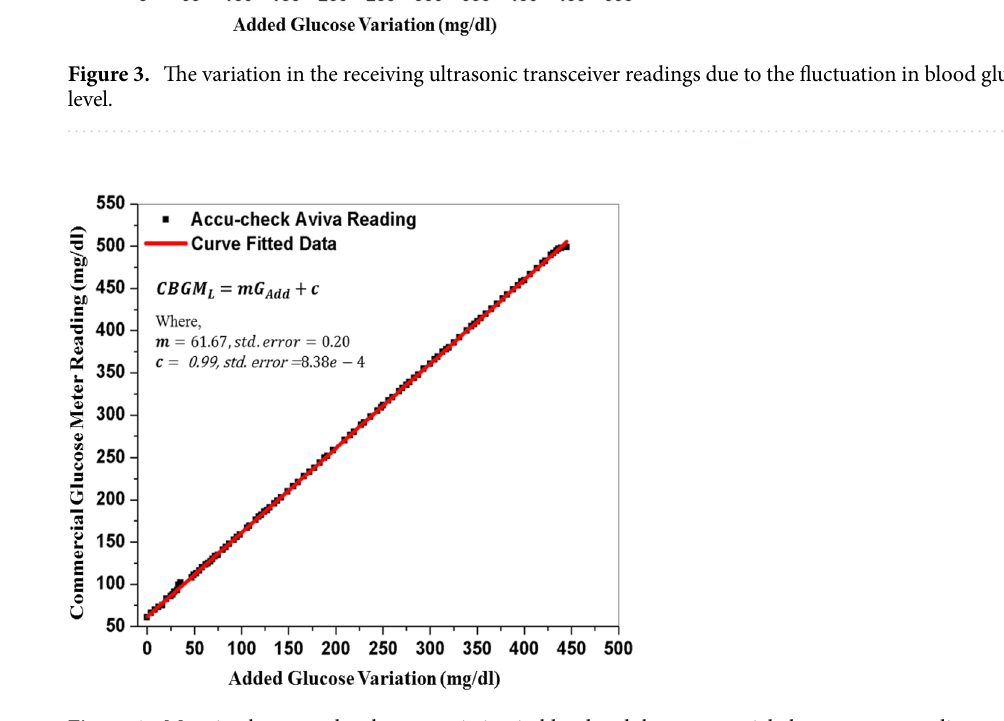
Figure 4. Mapping between the glucose variation in blood and the commercial glucose meter